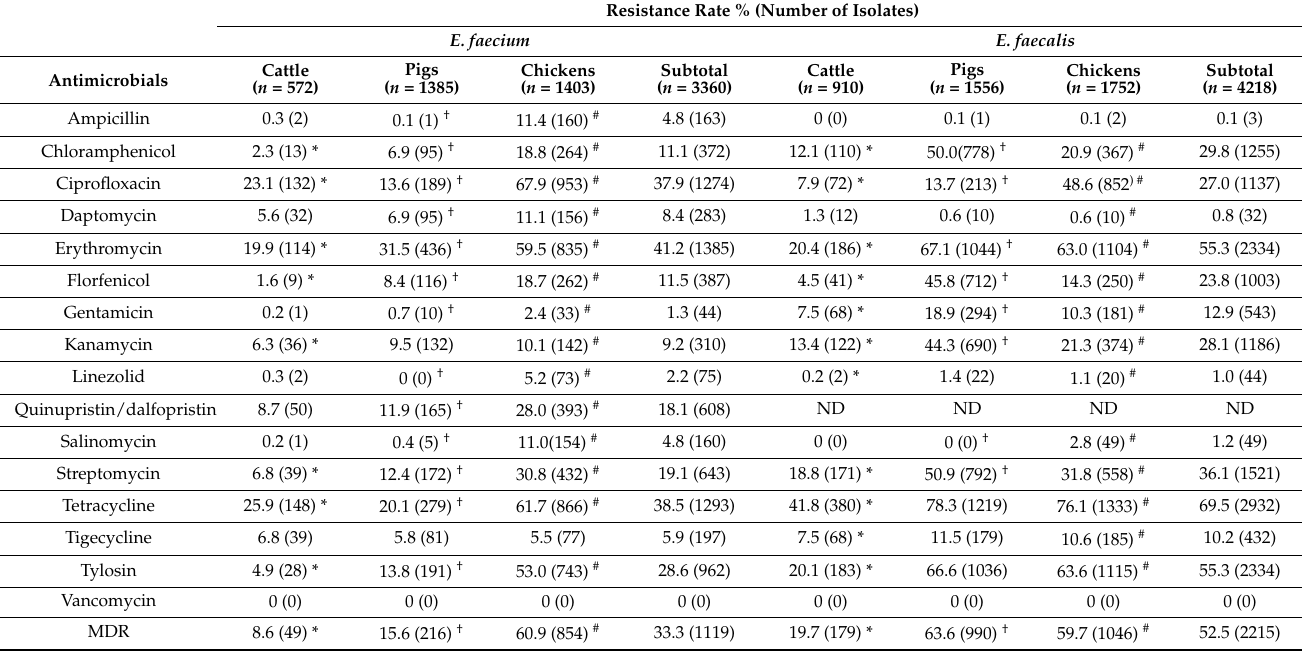
Table 1. Antimicrobial resistance rate in E. faecium ( n = 3360) and E. faecalis (n = 4218 ) recovered from cattle, pigs, and chickens between 2010 and 2019 in Korea.